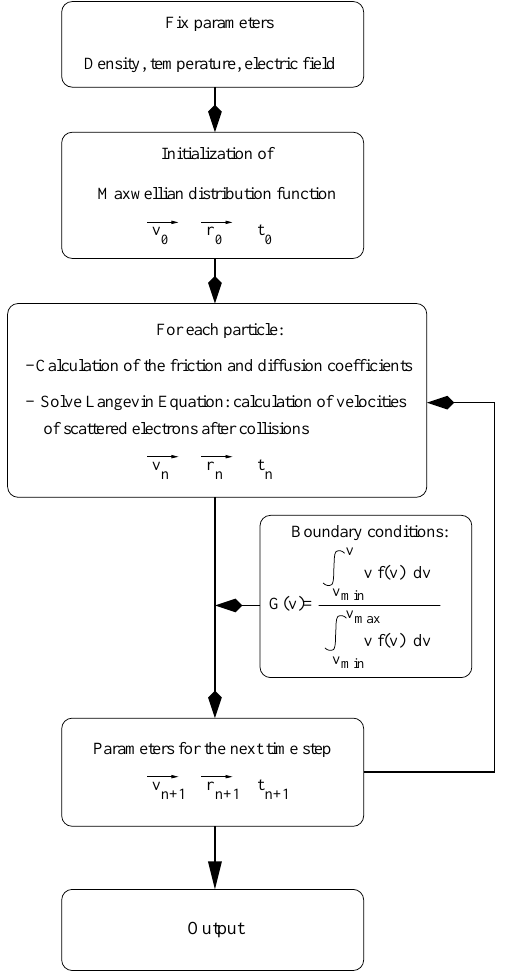
Fig. 5. A diagram of the computational scheme used in the paper.